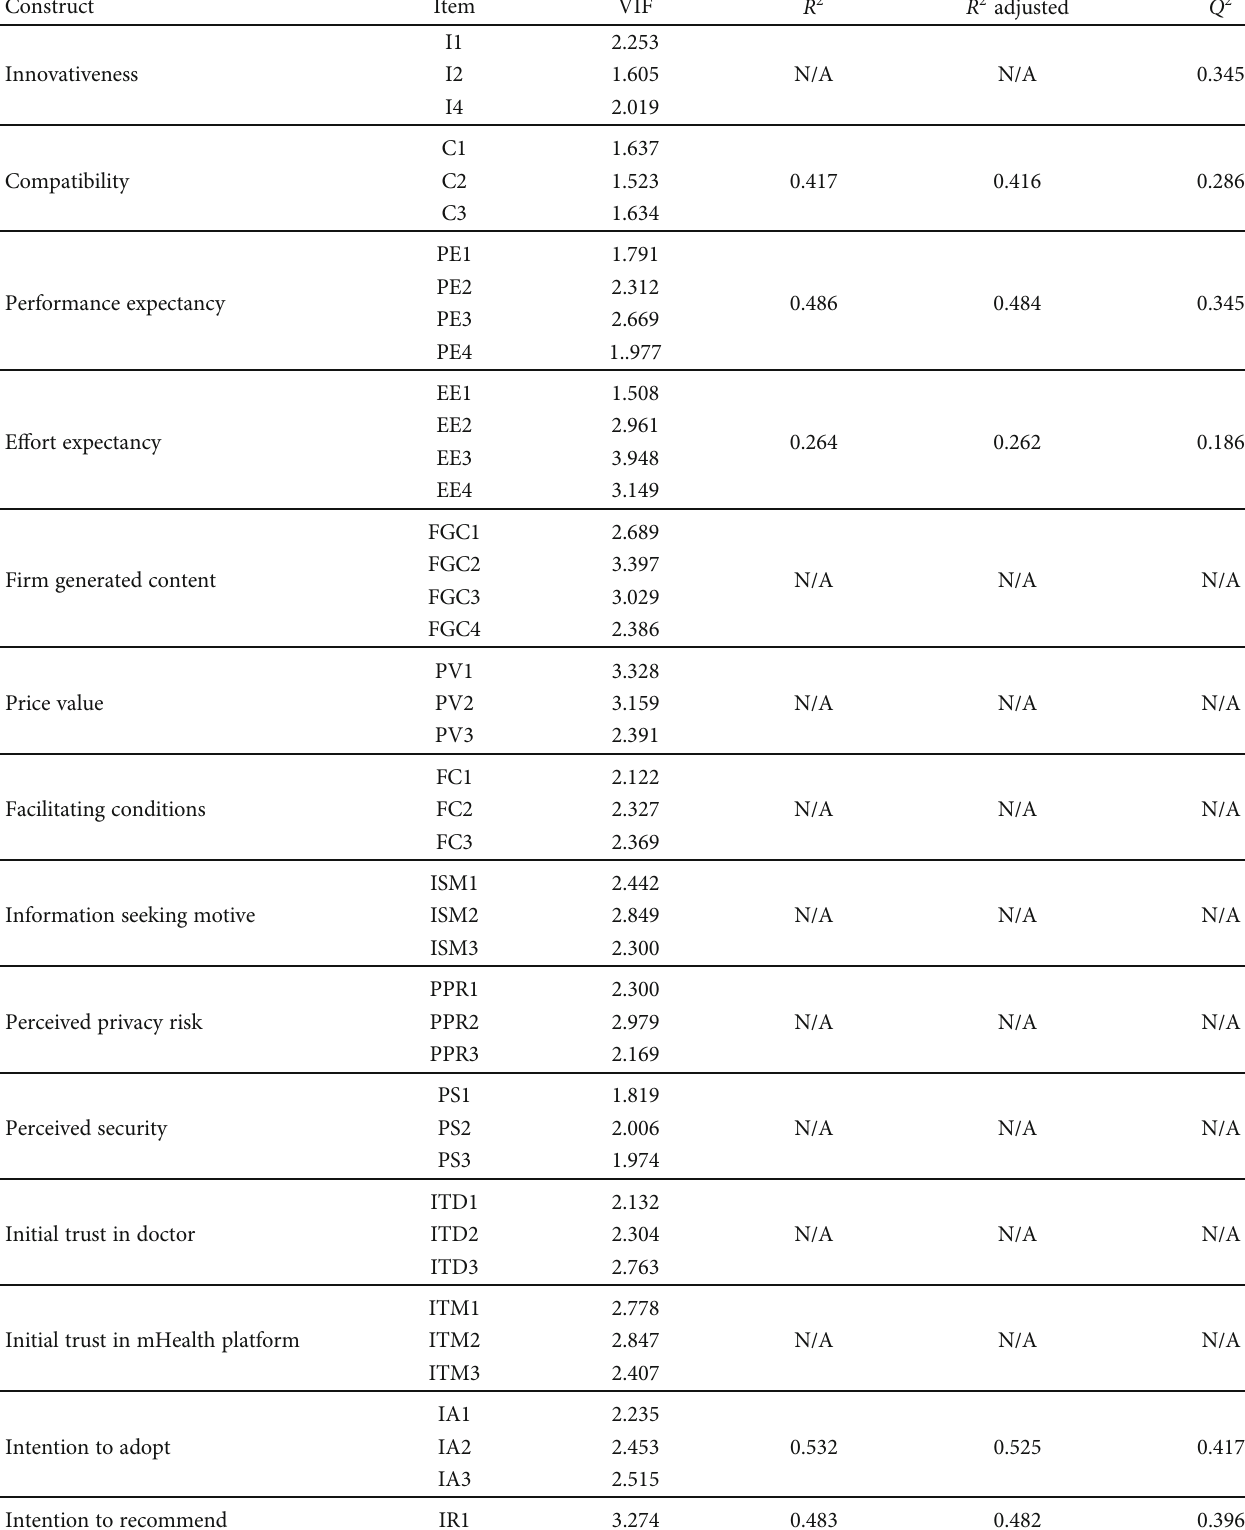
Table 5: Formative indicators ’ quality